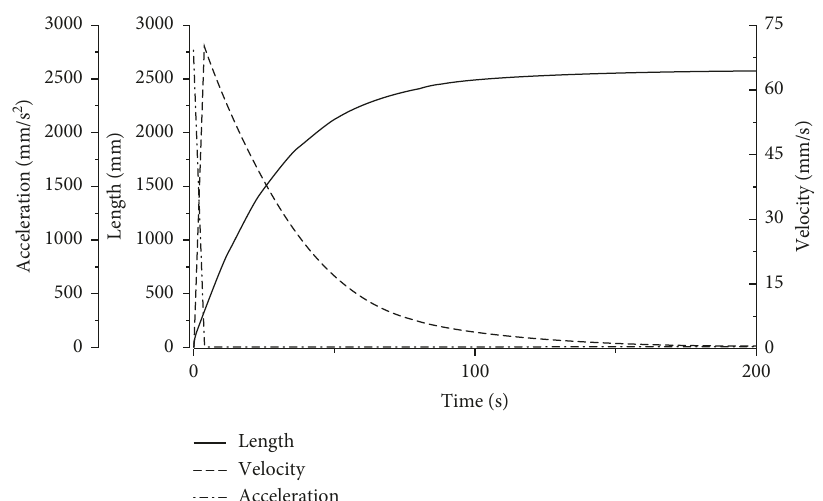
Figure 19: Dynamic curves of the mass center of one of the rotary pairs.